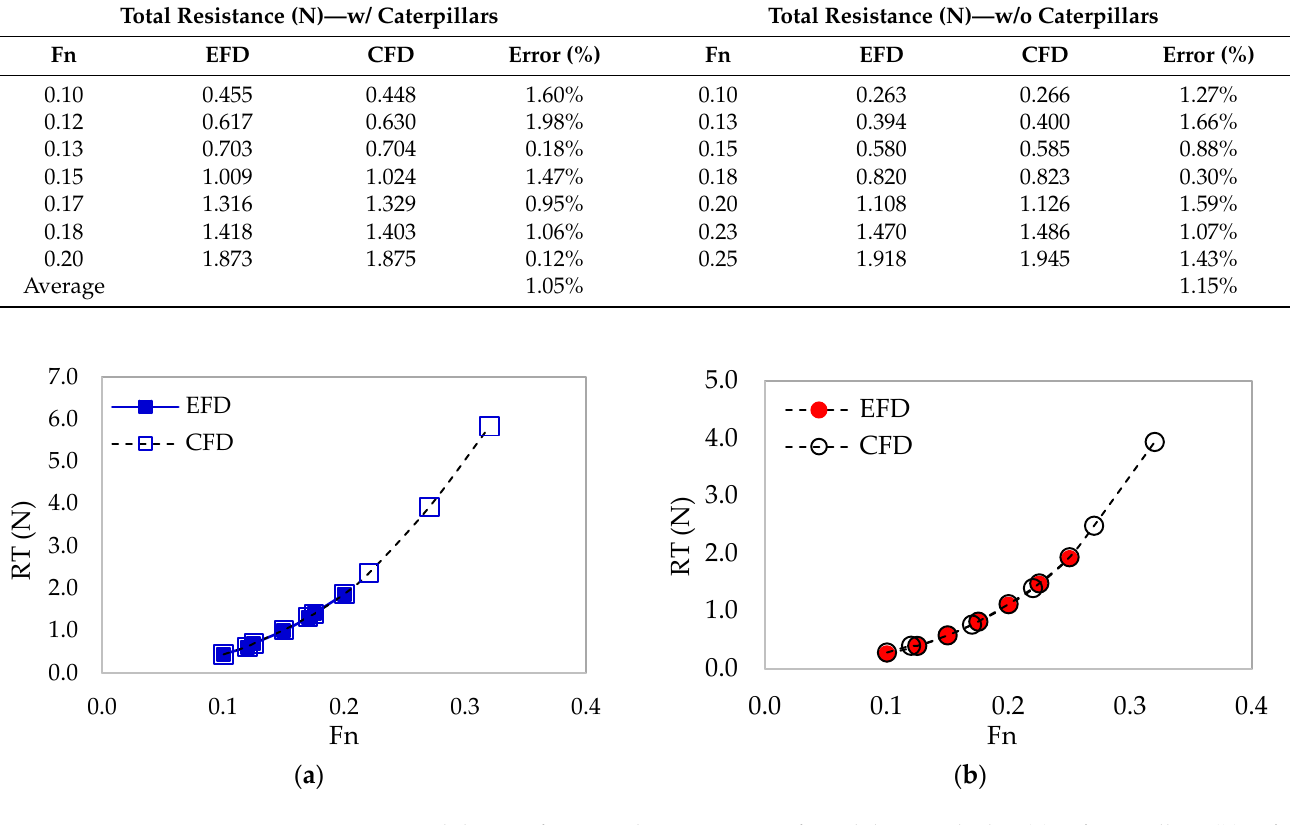
Table 5. Validation of numerical simulation with experiment.